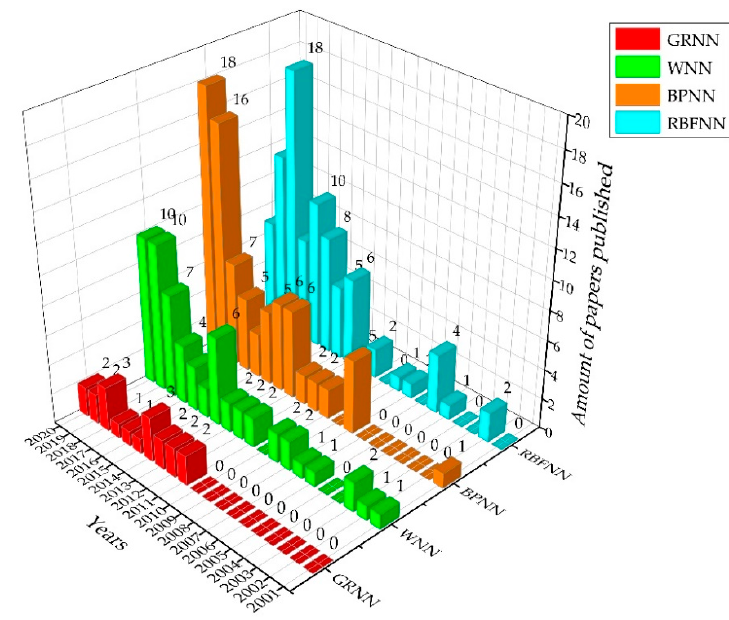
Figure 2. Annual publication volume of 4 kinds of ANNs in the oil and gas field. From 2001 to 2020, the percentages of the 4 types of ANNs in the oil and gas industry indicate that RBFNN is used most frequently, accounting for 35.86% of papers, followed by BPNN and WNN, and GRNN is the least frequently used, accounting for only 8.02%. However, since 2010, the volume of publications of the four types of ANNs in the oil and gas industry has shown an increasing trend, among which WNN, BPNN and RBFNN [13] have increased significantly. From 2001 to 2020, the number of publications of 4 ANNs in the oil and gas field is shown in Figure 3.